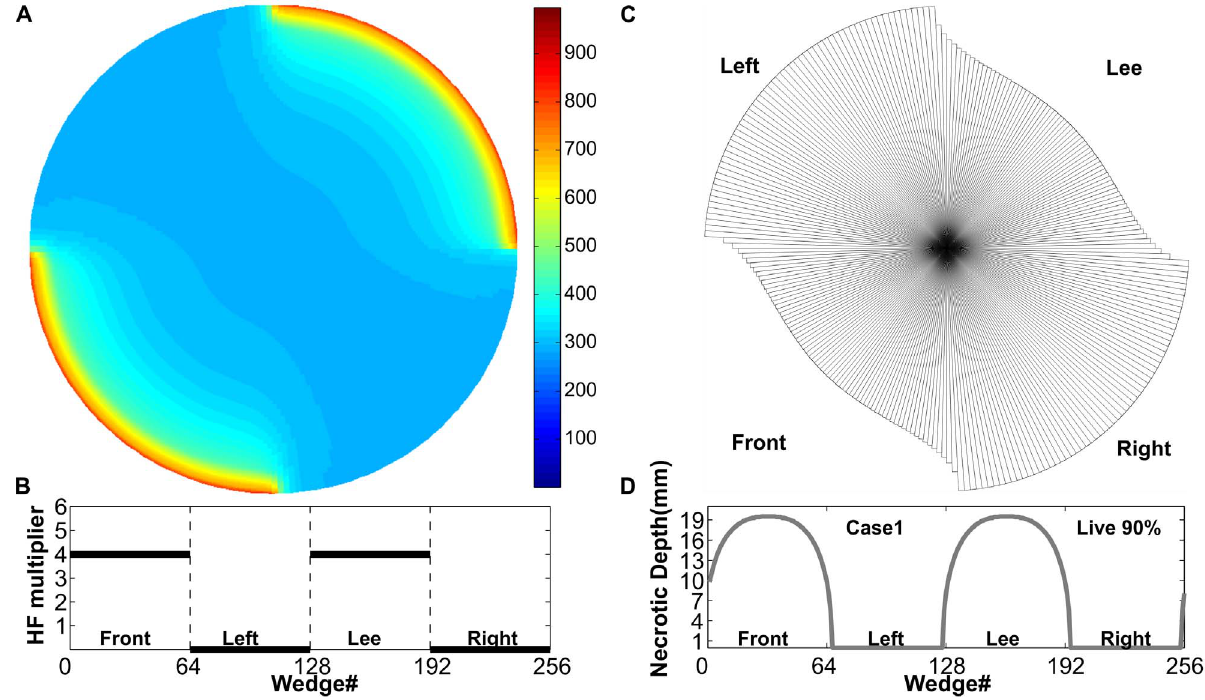
Figure 8. Forcing pattern and results for Case 1. A. Temperature distribution in the stem at the peak of heating process. B. Schematic illustration of heat forcing that was applied only to the front (upper right quadrant) and lee (lower left quadrant) sides as a plot of heat flux (HF) multiplier vs. the circumferential wedge number. The first wedge is located between 0 and 1.4 degrees from the top (‘‘north’’) of the stem and wedge numbers are increased in the clockwise direction. At each wedge, the HF multiplier is applied to the circumferential mean heat-flux forcing. C. Remaining uninjured stem after heating. D. Necrotic depth of each wedge of the stem.